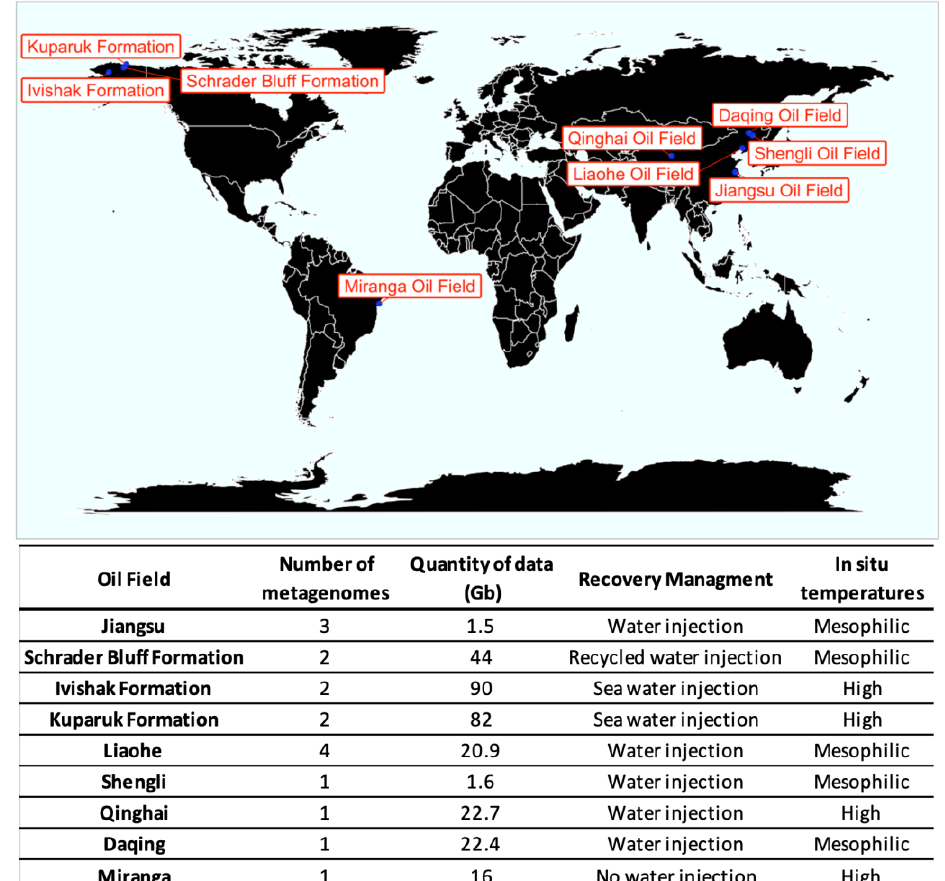
Figure 1. Geographic distribution of metagenomes. The number of metagenomes and the amount of information in gigabytes from each site are in parenthesis.